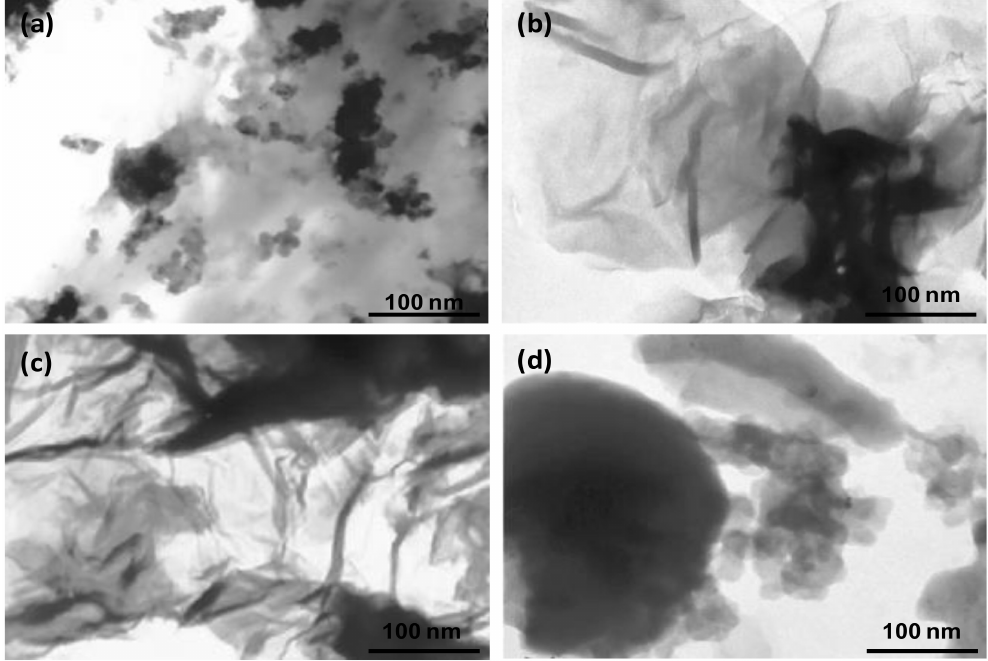
Figure 3. TEM images of EGO 4 ( a ), EGO 14 ( b ) EGO 15 ( c ), and EGO 21 ( d